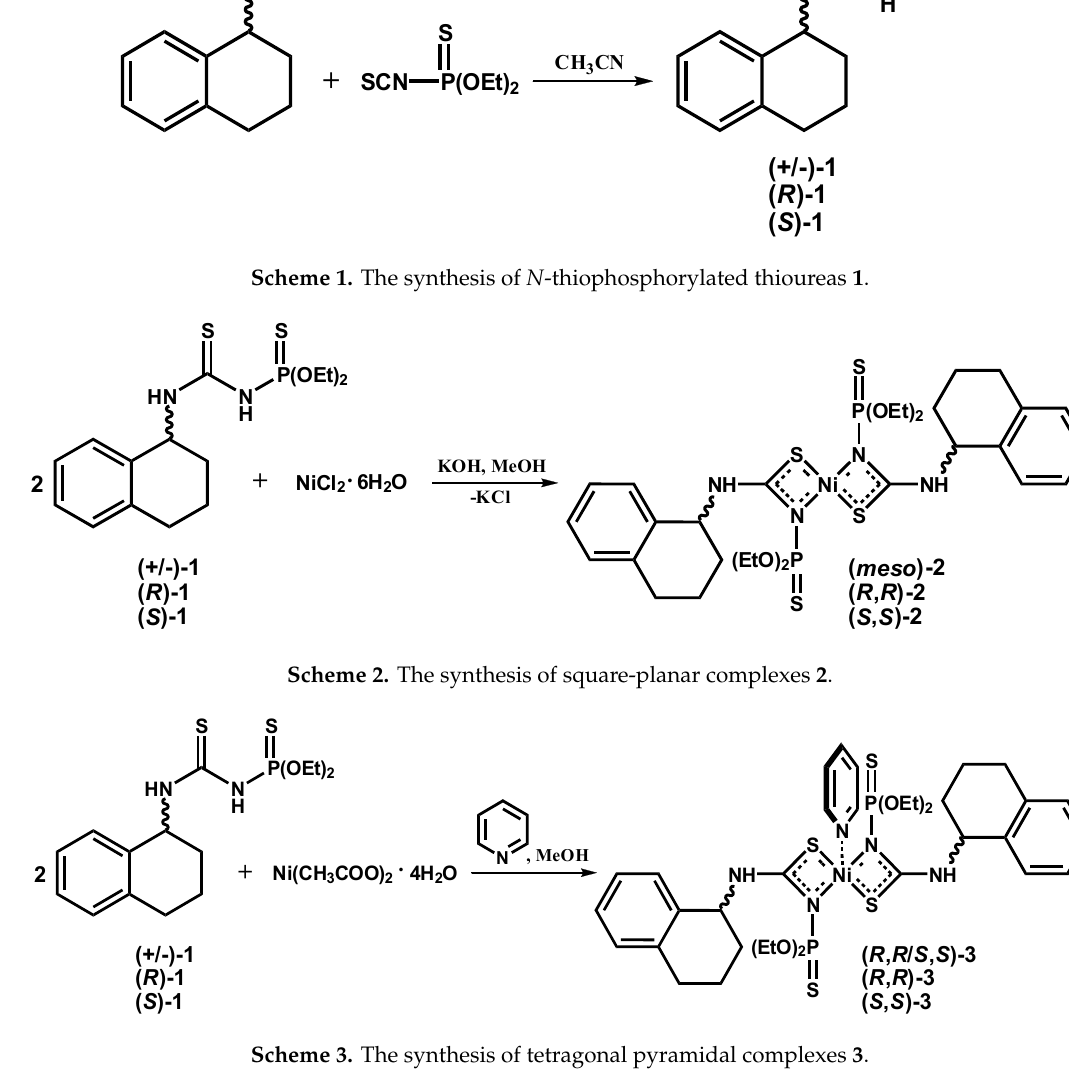
Scheme 3. The synthesis of tetragonal pyramidal complexes 3 .